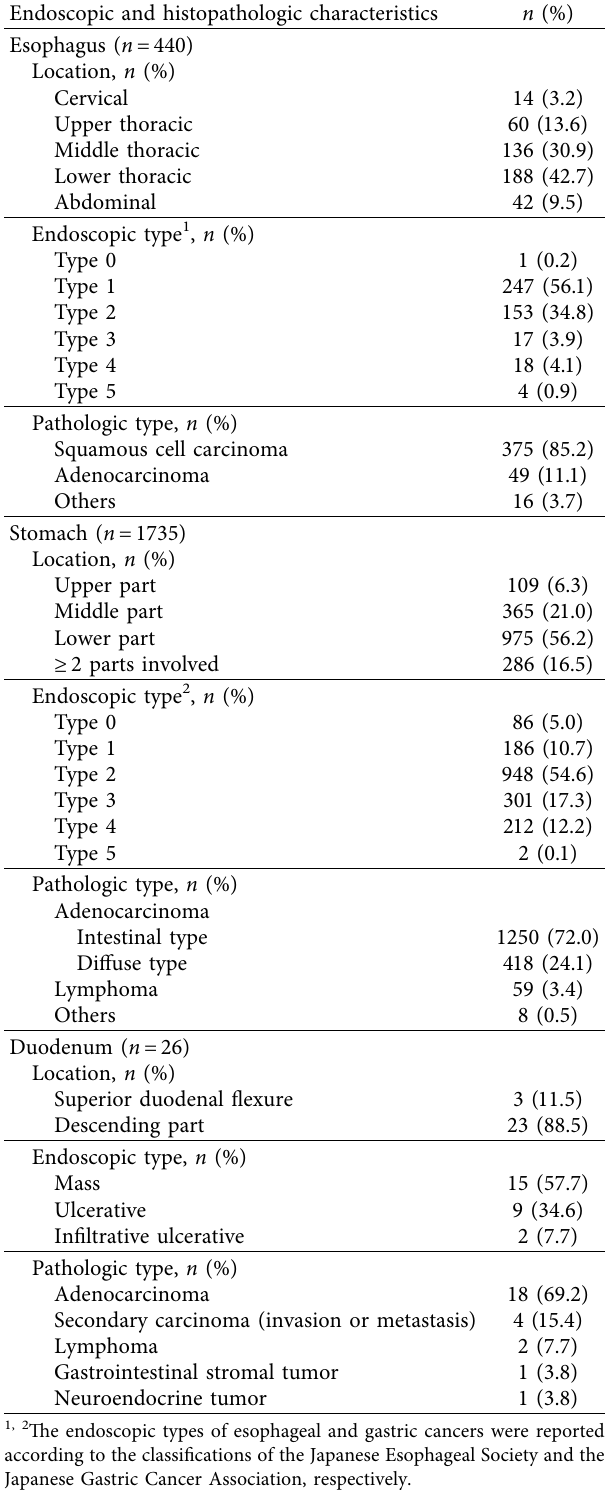
Table 1: Endoscopic and histopathologic characteristics of the upper gastrointestinal malignancies. Endoscopic and histopathologic